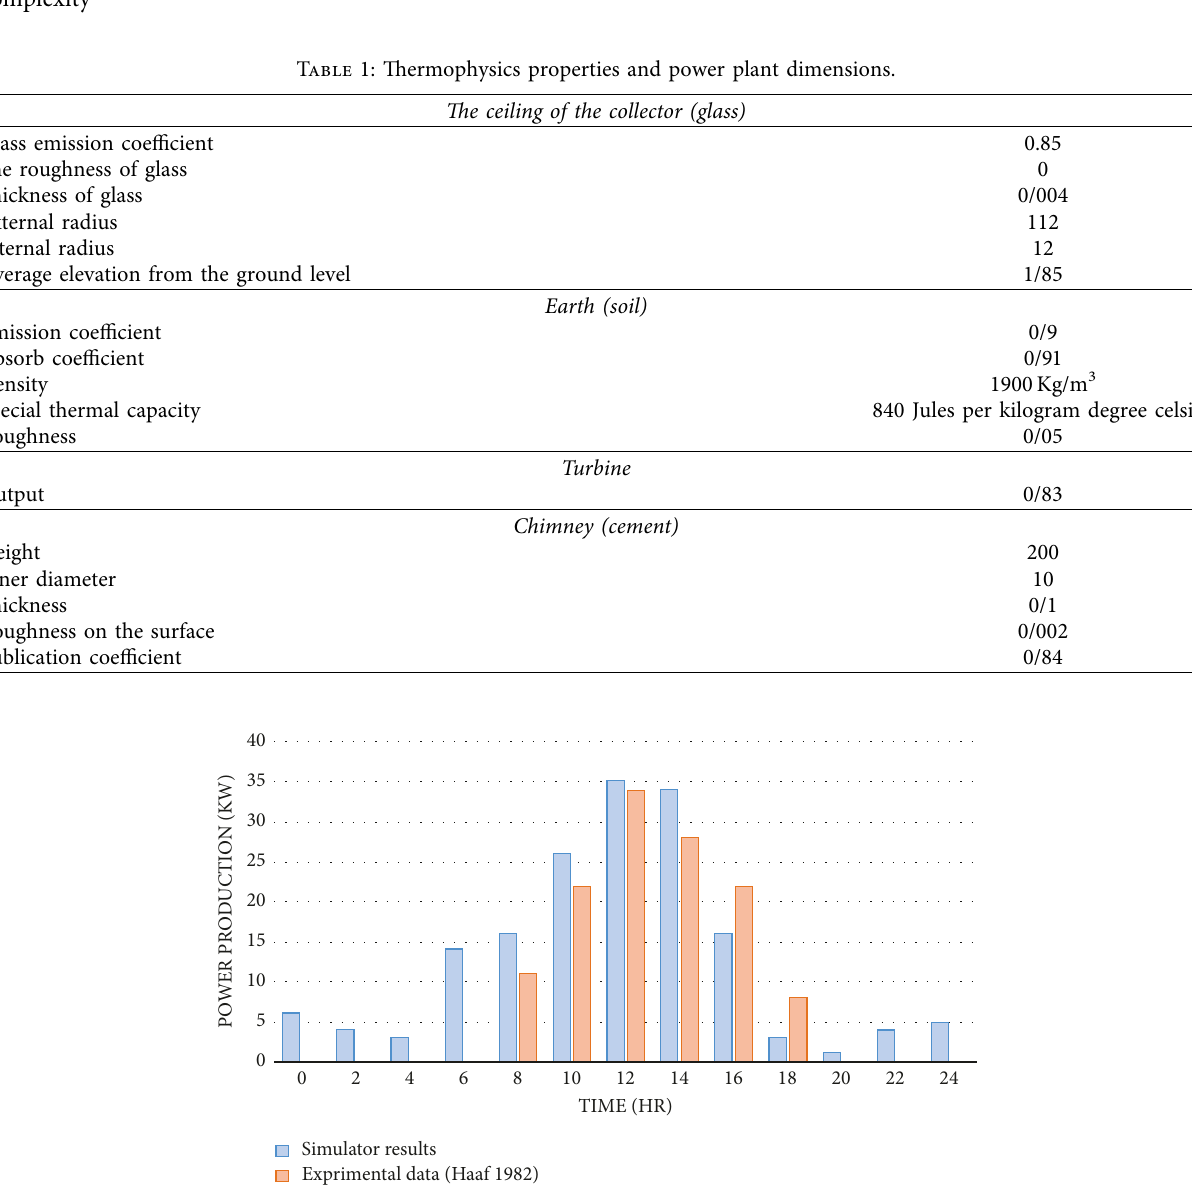
Figure 3: The output of Manzanares power plant in Spain and its comparison with experimental data. Table 2: Comparison of production power and energy production in